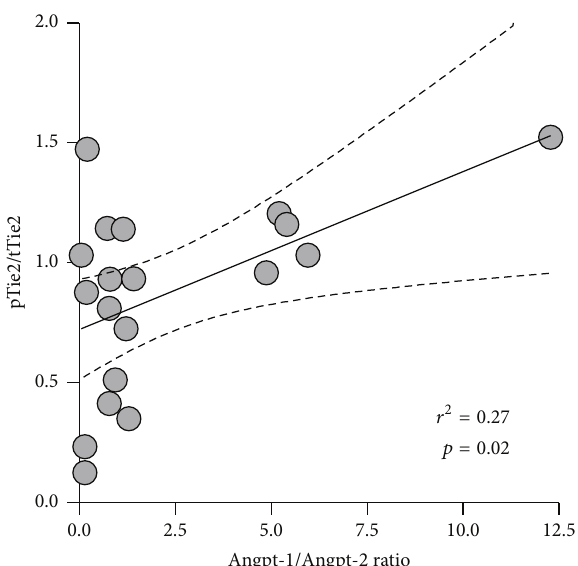
Figure 3: Linear regression shows the correlation between the Angpt-1/Angpt-2 ratio and the phosphorylated Tie2/total Tie2 ratio